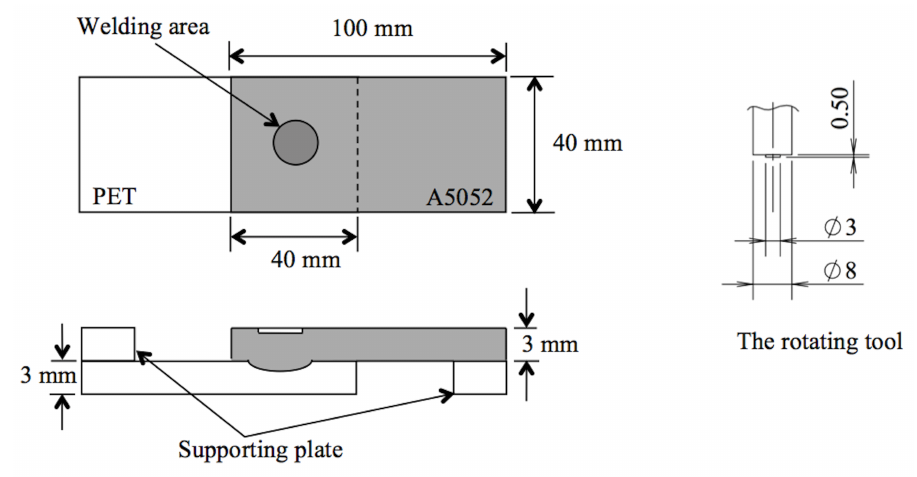
Figure 1. Schematic diagram of lap joint specimen positioning details ( left ) and the rotating tool dimension ( right ).